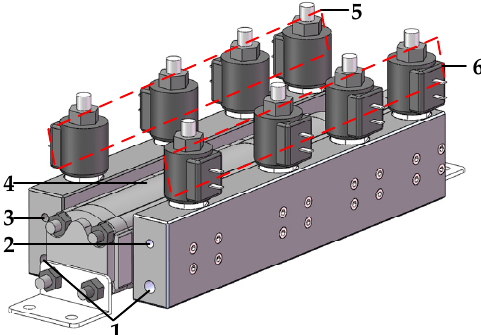
Figure 2. Structure diagram of DHT. (1) Low-pressure port T for connecting the tank; (2) Oil port P for connecting the oil source; (3) Oil port A for connecting the load; (4) Flow dividing and collecting system; (5) Outlet control valve group; (6) Inlet control valve group.